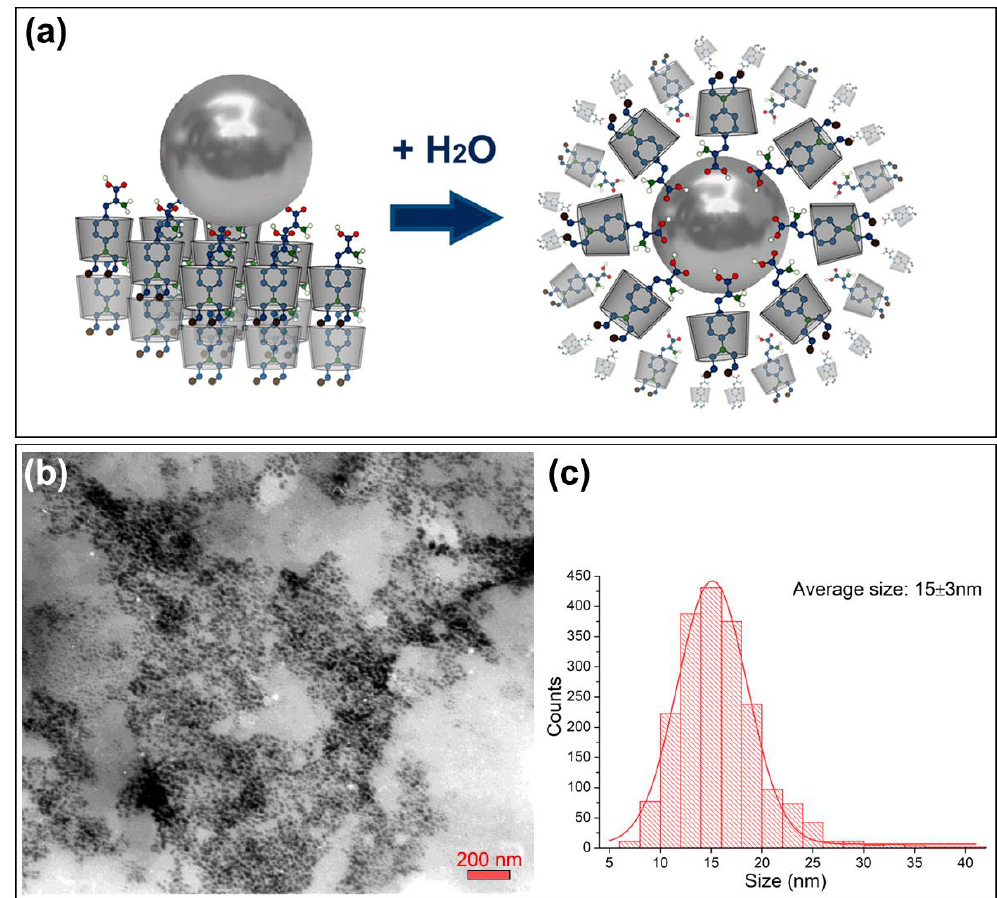
Figure 7. ( a ) Schematic representation of the solubilization process of AgNPs onto β CD–Mel crys- talline complex forming the β CD–Mel–AgNPs nanosystem in colloidal solution, ( b ) TEM micrograph of βCD– Mel – AgNPs colloidal nanosystem with its respective size distribution histogram ( c ).